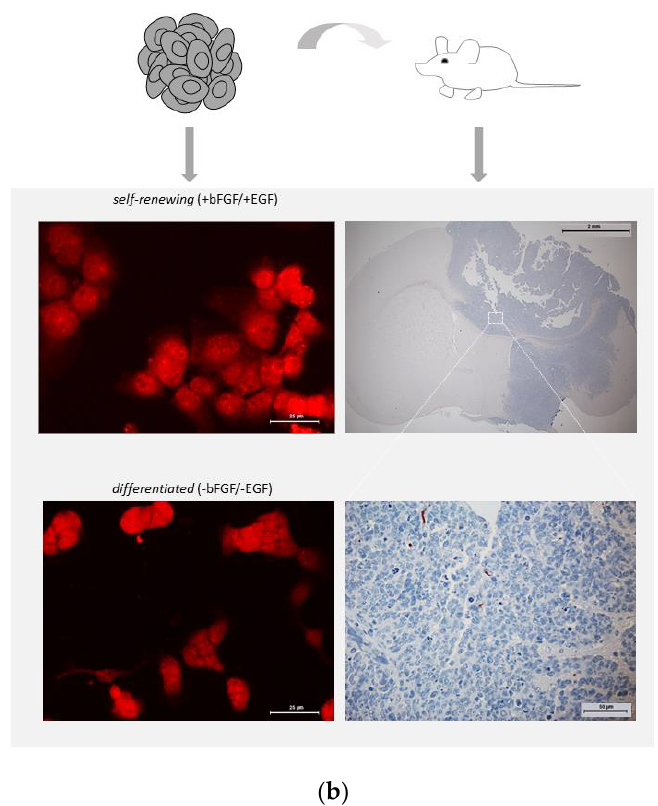
Figure 3. Comparative assessments of GFAP expression in vitro and in vivo. ( a ) GFAP Ind or ( b ) GFAP Const GSCs maintained exclusively under self-renewal promoting condition were implanted into the brain of nude mice to generate tumors. The right panels show immunohistochemical staining of xenograft tumors. Magnification 1.6 × (top panels, scale bars 2 mm) and 40 × (bottom panels, scale bars 50 µ m). For comparison, GFAP patterns of GSCs cultured under self-renewal promoting ( top ) or di ff erentiation-inducing ( bottom ) condition is shown in the left panels. Immunocytochemical staining for GFAP. Magnification 40 × , scale bars 25 µ